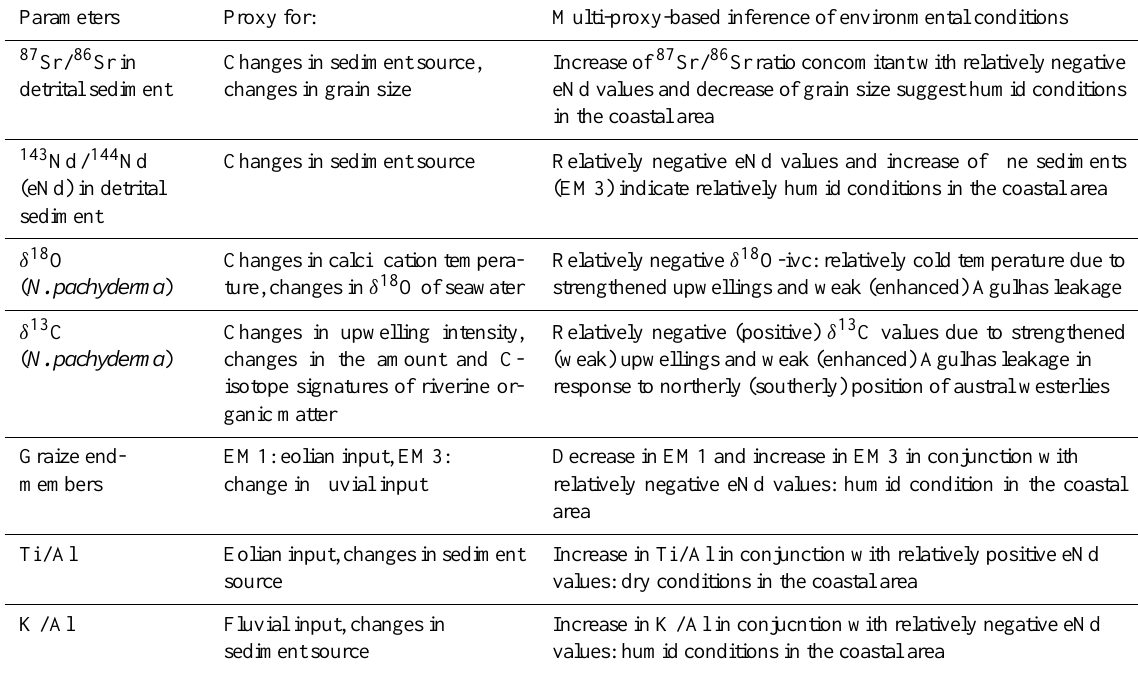
Table 3. Summary of geochemical parameters presented in this study and paleo-environmental interpretation.